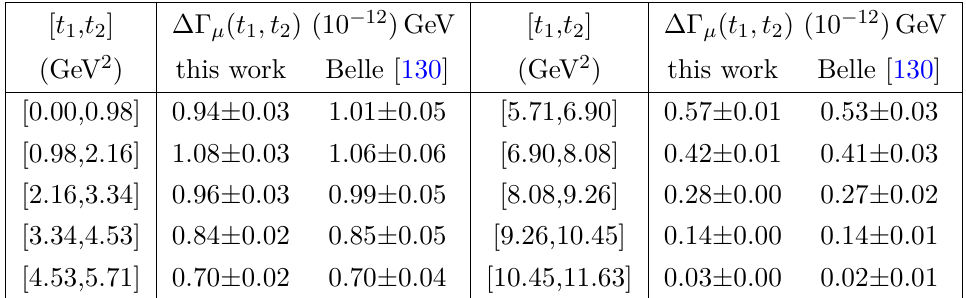
Table 6 . Theory predictions for B → Dµν µ in different bins compared against the Belle data.